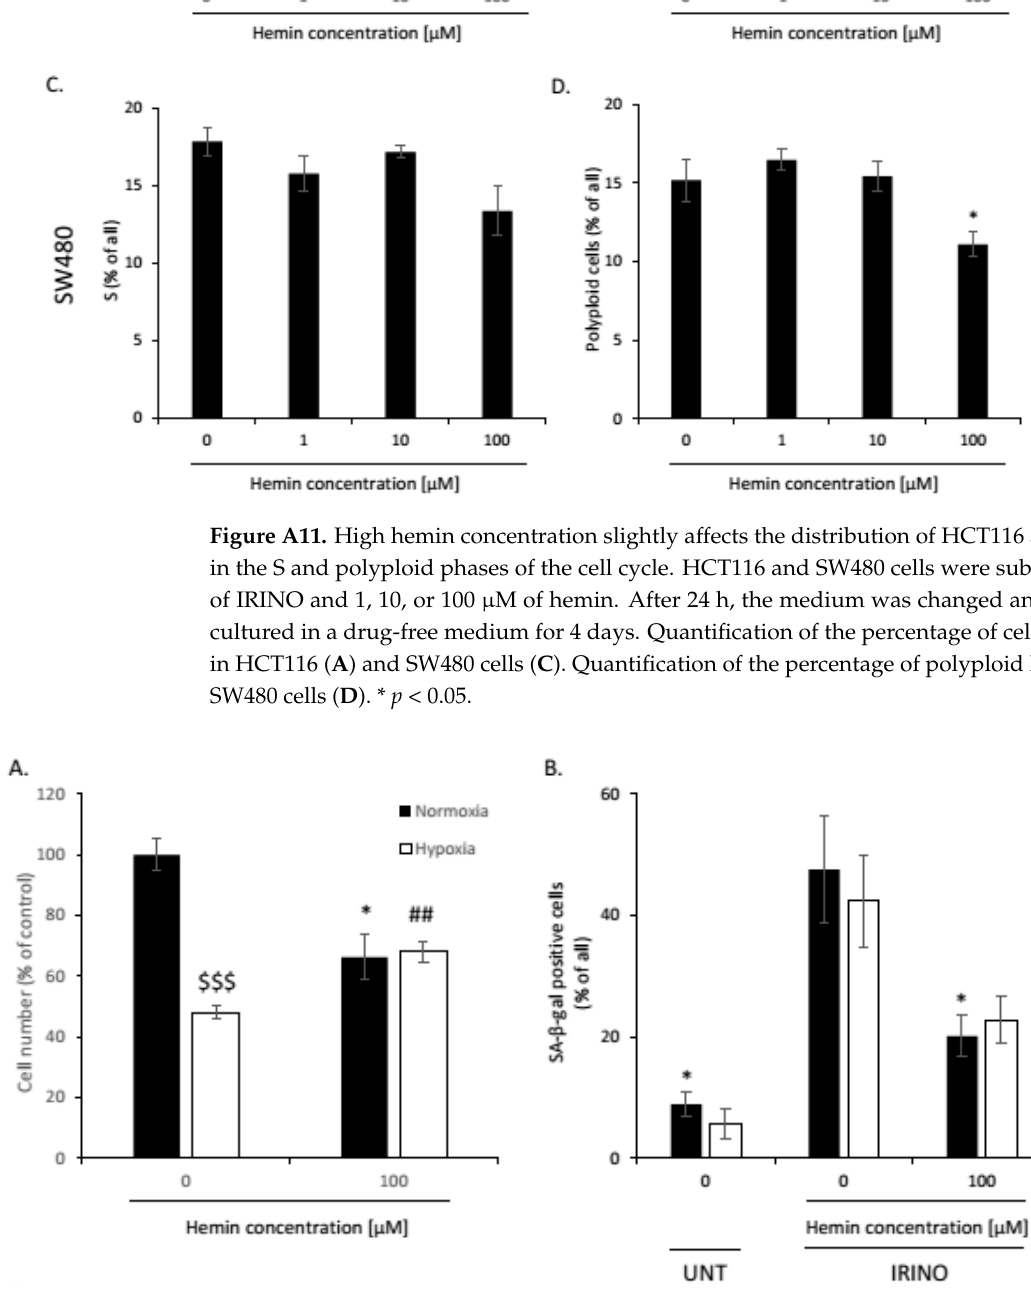
Figure A12. High hemin concentration correlates with an escape from senescence of hypoxic SW480 cells: cell number and activity of SA- β -Gal. Cells were cultured in parallel in normoxia or hypoxia. Cells were exposed to 100 µM hemin. Control cells were subjected to IRINO and NaOH in the cor- responding dose. ( A ) Evaluation of cell number. Cell number was counted using Bürker’s chamber. ( B ) Activity of SA- β -Gal enzyme in IRINO-treated cells subjected to hemin under normoxic or hy- poxic conditions. Detection of the enzyme was performed on cytospined cells. ( C ) Quantification of SA- β -Gal positive cells after treatment with hemin. Representative photos were acquired using light microscopy. Original magnification 200 x, scale bar 50 µM; Each bar represents mean ± SEM, n ≥ 3; * p < 0.05—vs. control normoxia; ## p < 0.01—vs. control hypoxia; $$$ p < 0.001—normoxia vs. hy- poxia.